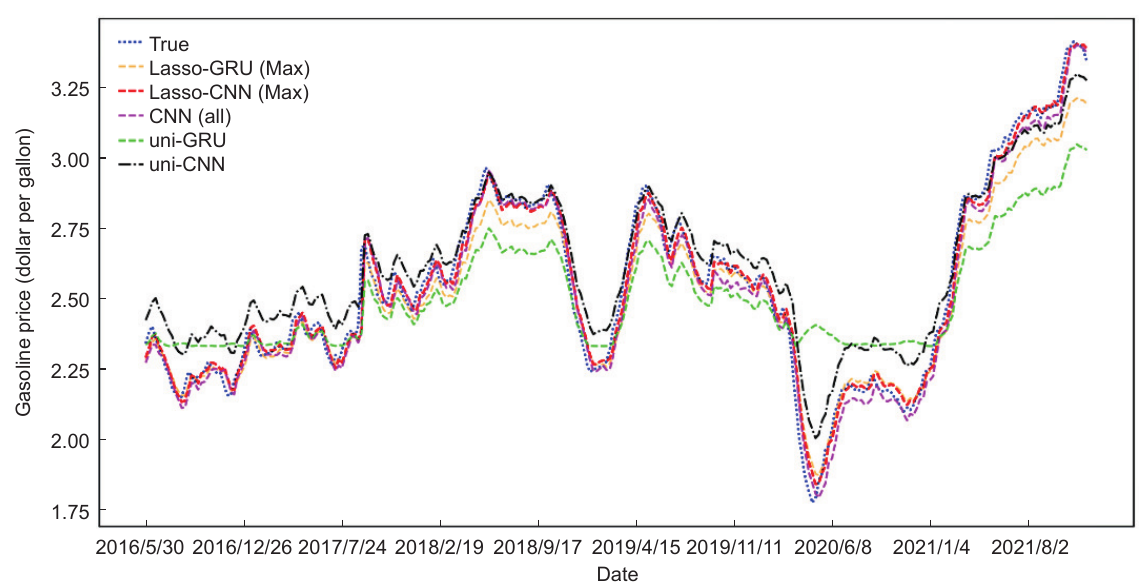
Fig. 2 Gasoline prices of the entire nation and their prediction based on the new method and alternative Table 3 RMSE of forecasting gasoline prices in various regions based on the new method and alternative methods. Region